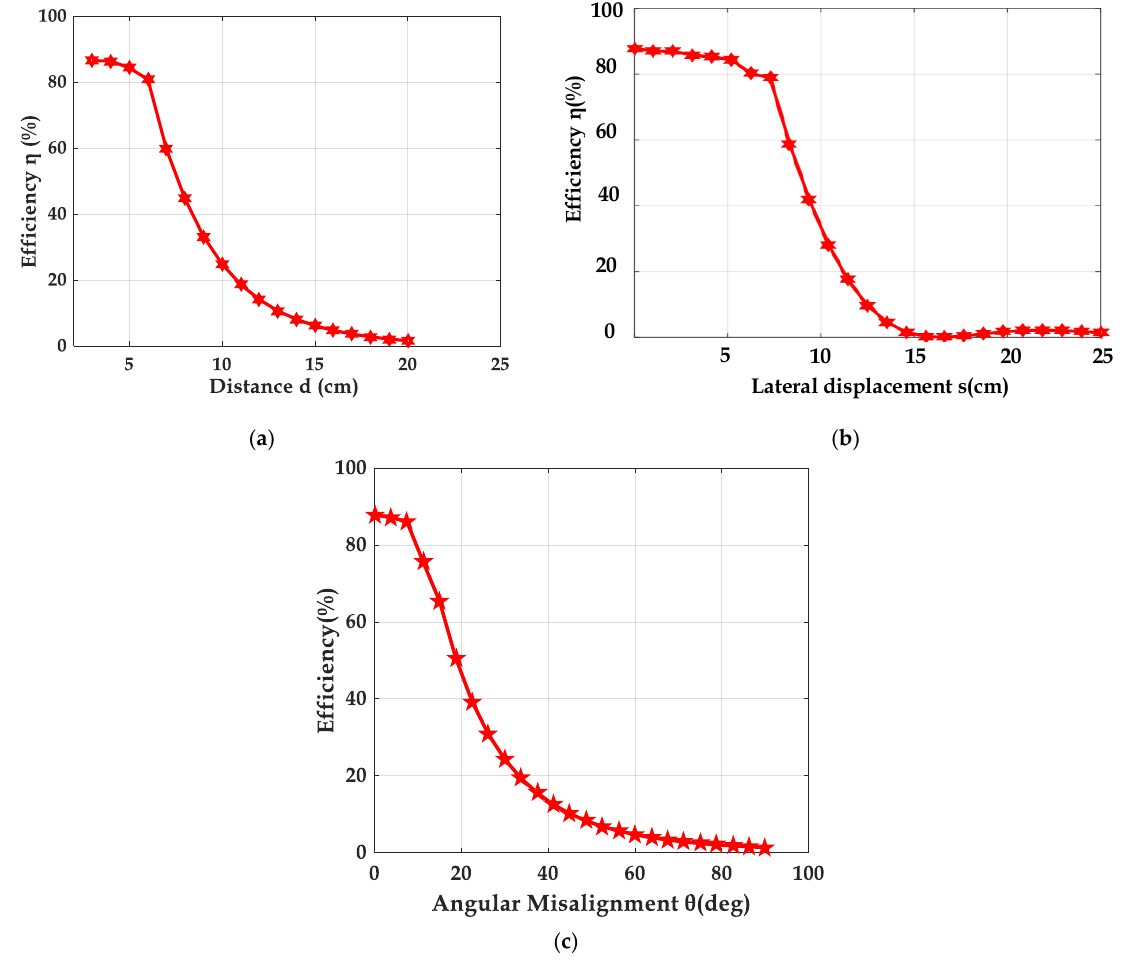
Figure 9. Simulation results of the system efficiency for R s = R L = 50 Ω ; ( a ) distance d between the transceivers; ( b ) lateral displacement of the RX coil for d = 5 cm; ( c ) angle deviation θ.